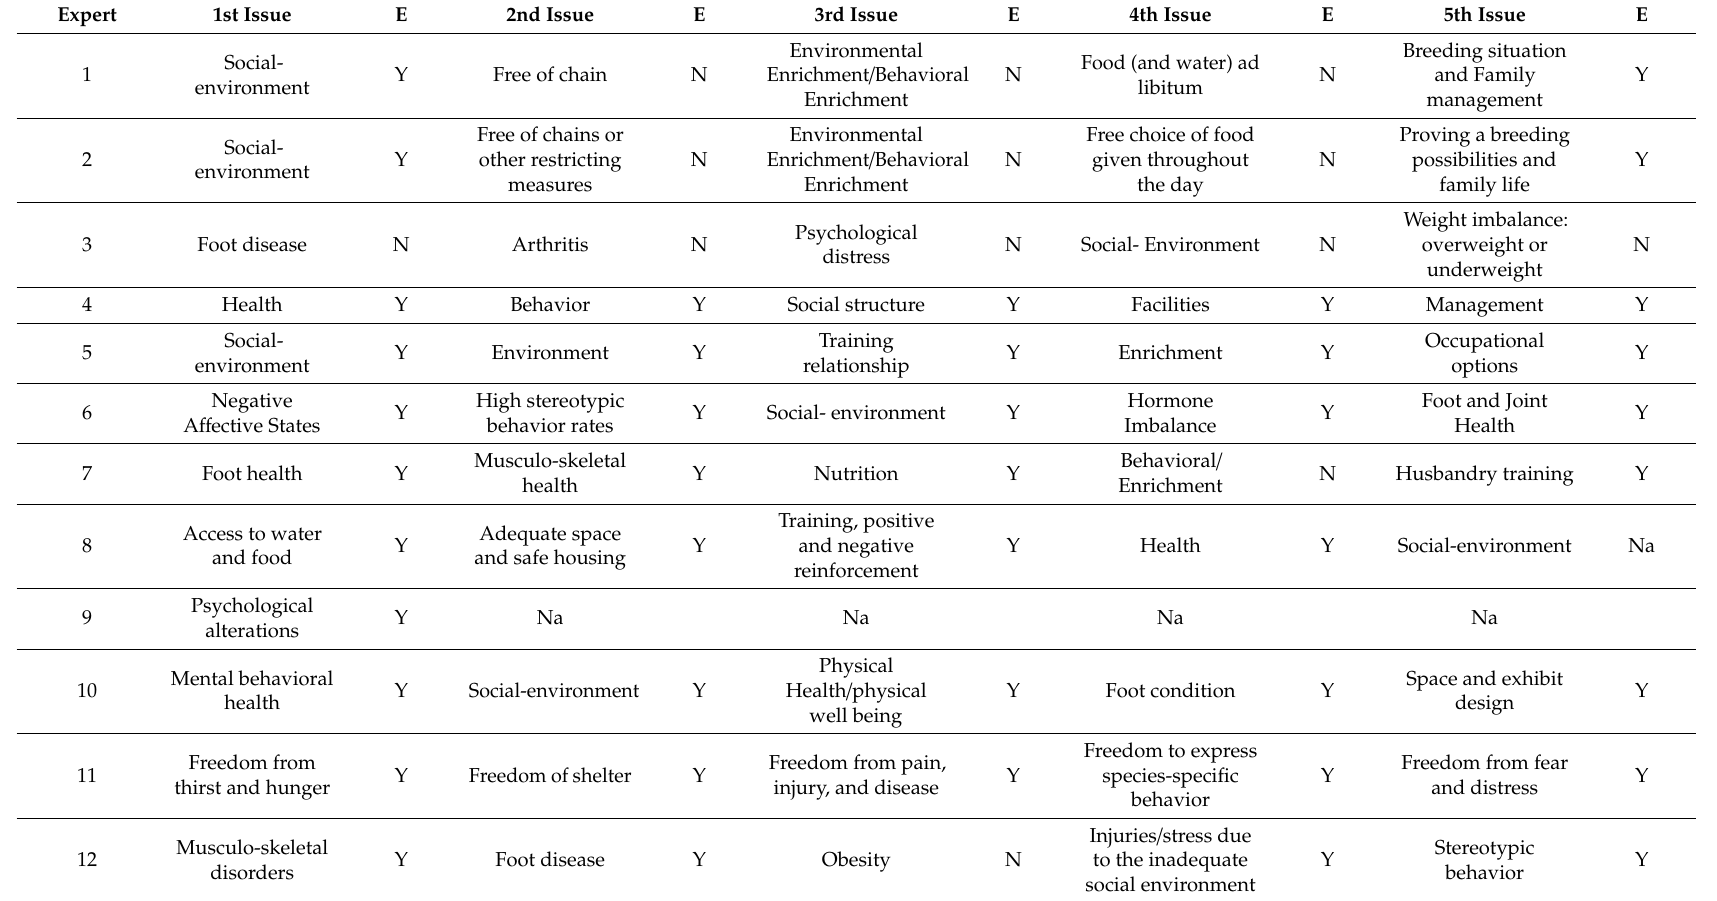
Table 1. Results of the survey regarding issues a ff ecting the welfare of elephants in captivity and possible di ff erences in relation to semi-captive individuals. E stands for whether the issue had equal relevance for semi-captive individuals compared to zoo ones; Y means that the experts answered it had equal relevance; and N means it had di ff erent